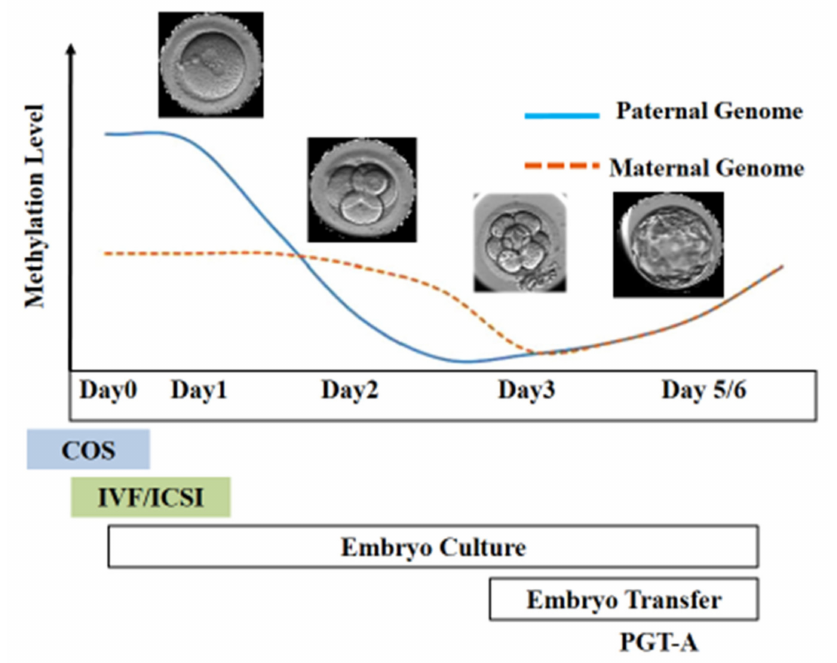
Figure 3. Epigenetic reprogramming during the early stage of embryo development. Post-fertilization, the paternal genome undergoes active demethylation, whereas the maternal genome is passively demethylated. The scheme illustrates the stage of development at which different ART techniques are